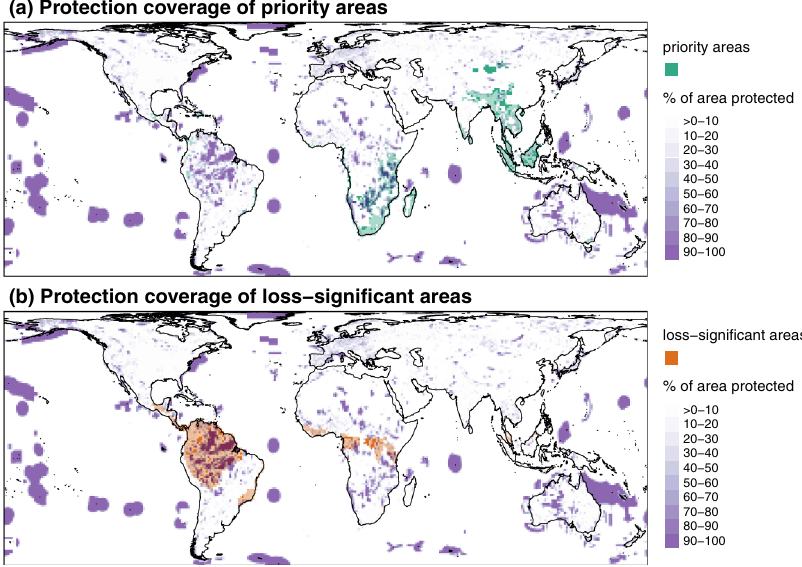
Fig. 6 Protection coverage of the areas of interest for conserving global mammalian PD. Spatial overlap between the percentage of area protected by the current network of protected areas and the priority areas (hotspots of gain in global expected PD if all species present in the cell are saved from extinction) ( a ) or the loss-signi fi cant areas (hotspots of loss in global expected PD if all species present in the cell become globally extinct) ( b ). The priority areas not protected appear in dark green, those slightly protected in light green, and those heavily protected in blue. The loss-signi fi cant areas not protected appear in dark orange, those slightly protected in light orange, and those heavily protected in